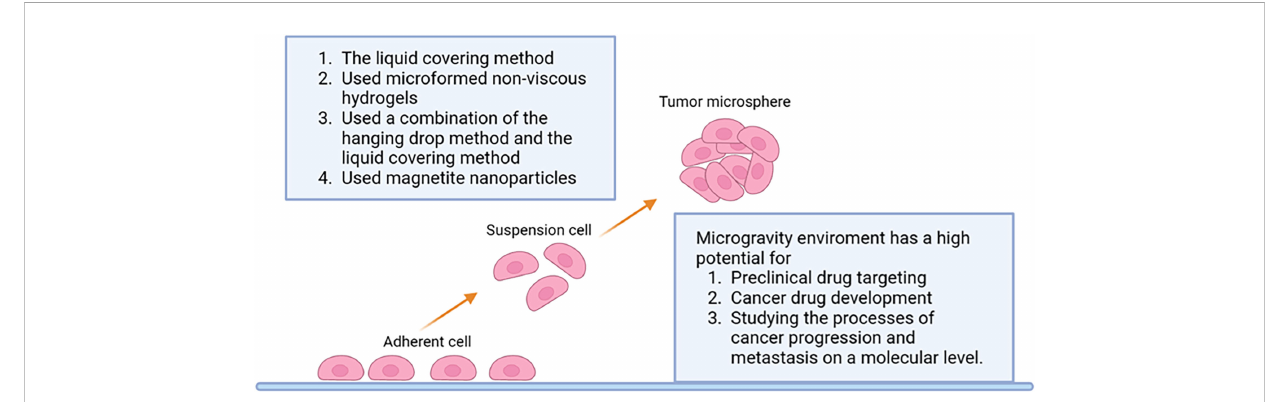
FIGURE 3 Schematic representation of the forced suspension